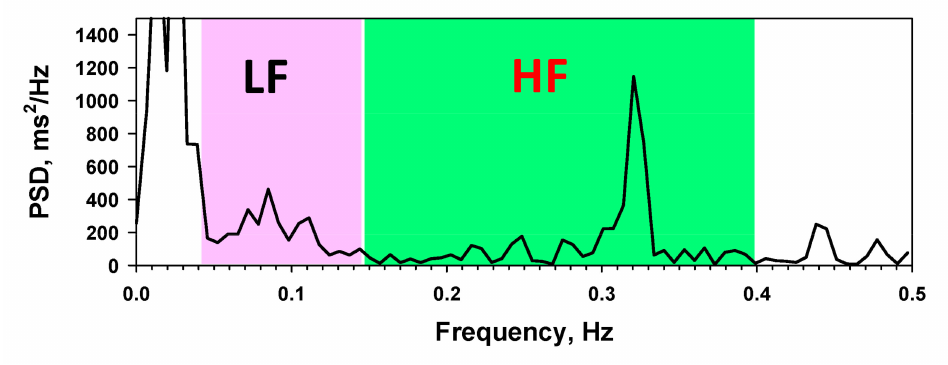
Figure 10. Power spectral density (PSD) features